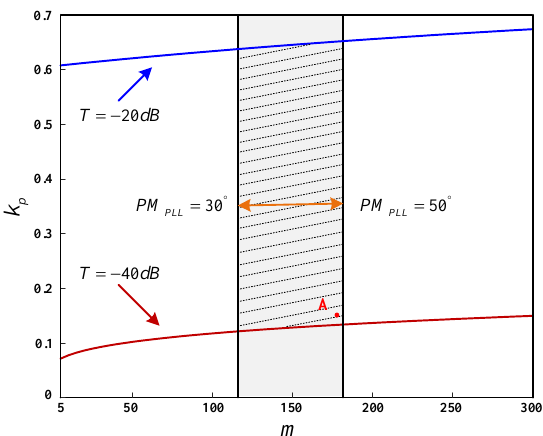
Figure 11. Relationship curve between k p and m . According to the above two constraints, the value range of k p is shown in the shade of Figure 11. It is worth noting that the effect of the PLL parameters on the output charac- teristic of GCI system is also an essential constraint. Therefore, it is necessary to further optimize the PLL parameter design method based on the above analysis.